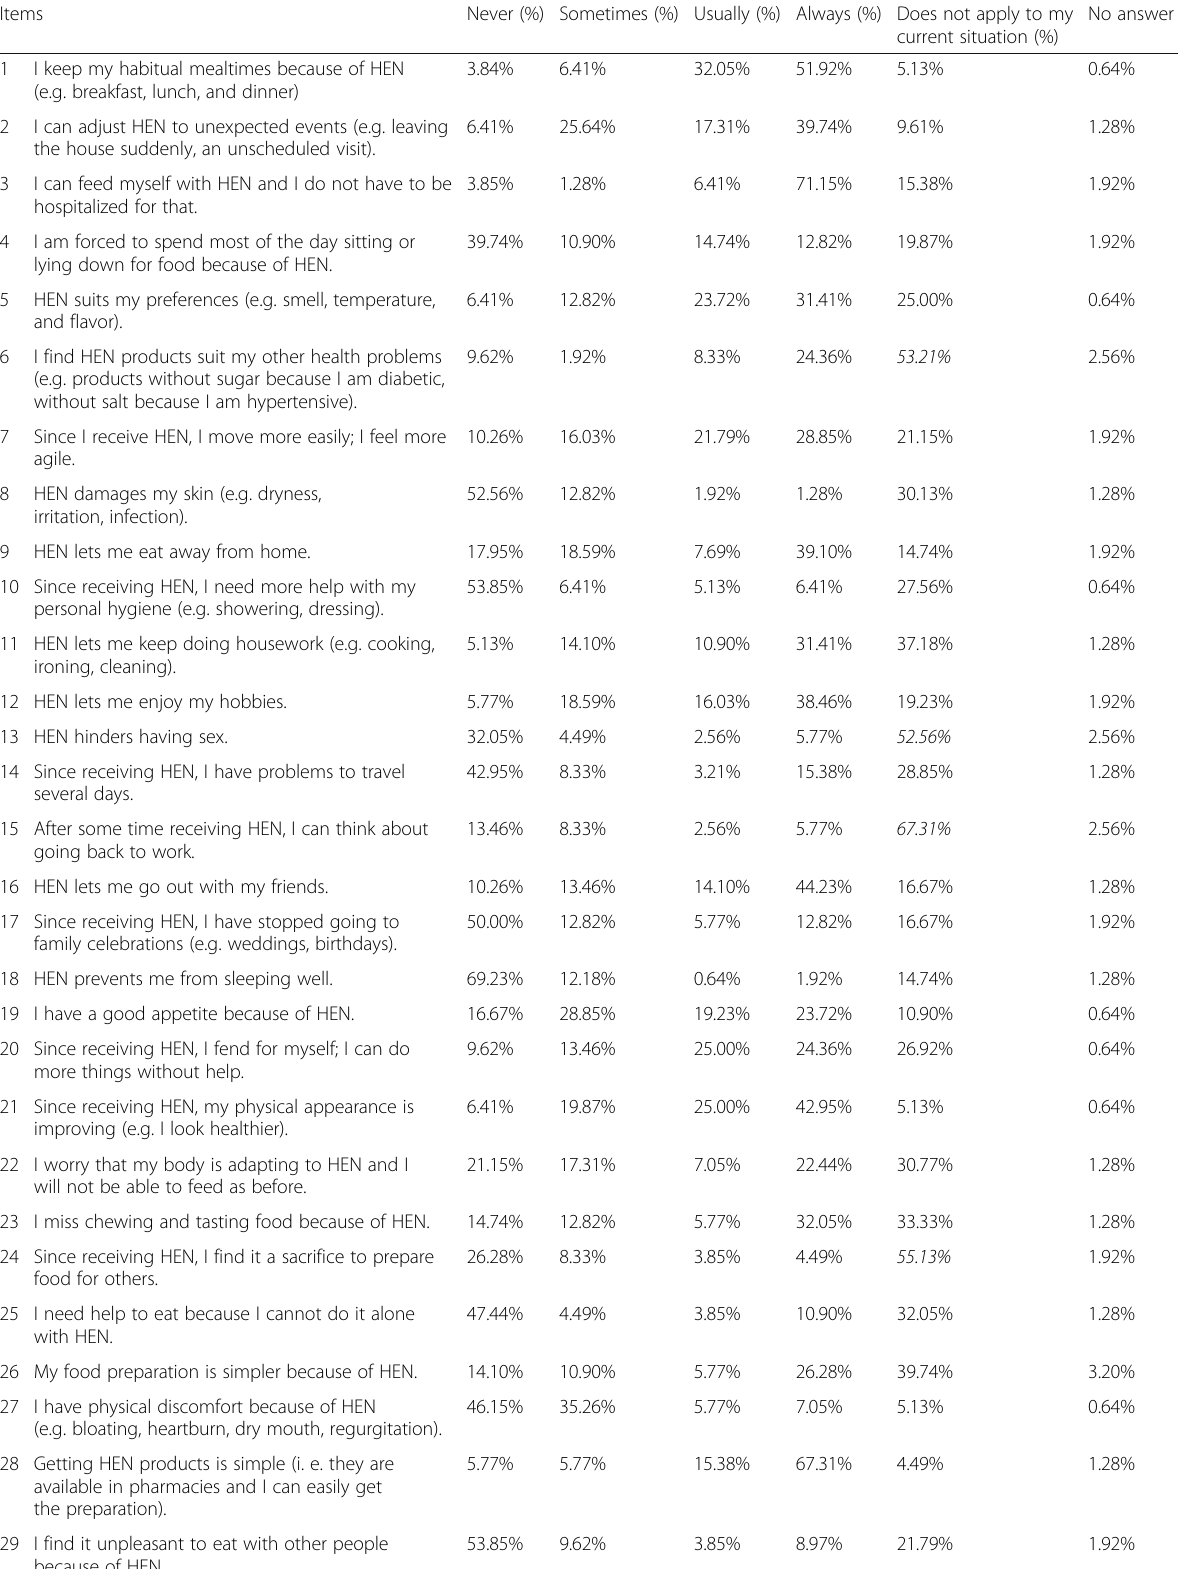
Table 3 Percentage of answers by category response in each item